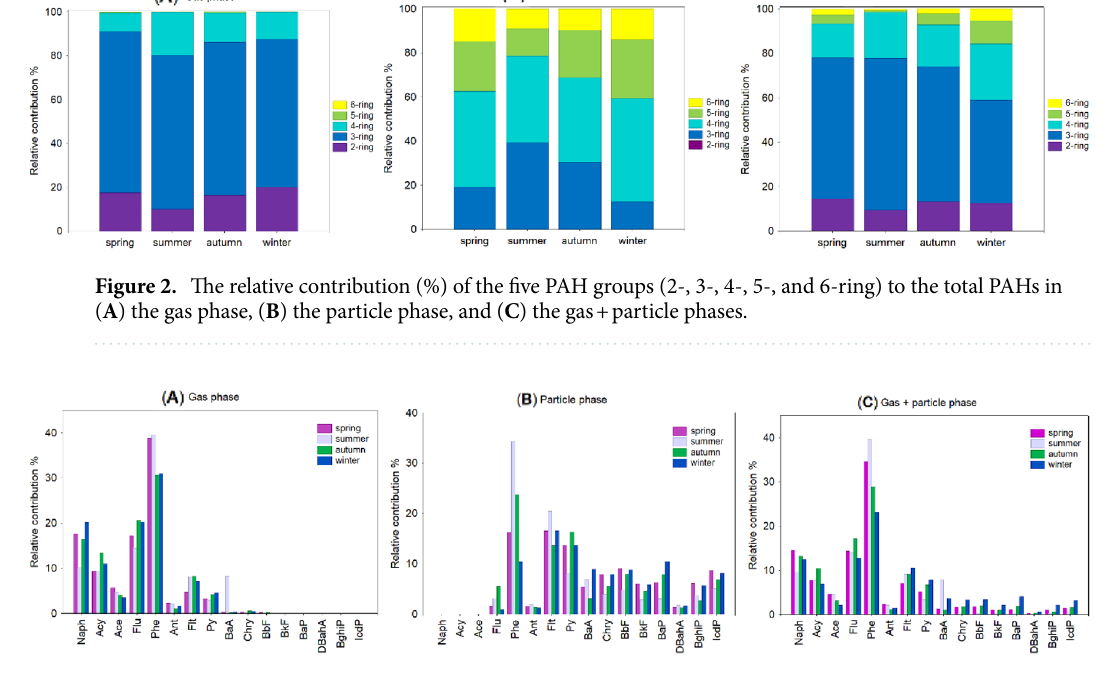
Figure 3. Mean relative contribution (%) of ( A ) the gas PAHs, ( B ) the particle PAHs, and ( C ) the gas + particle phase PAHs during the sampling